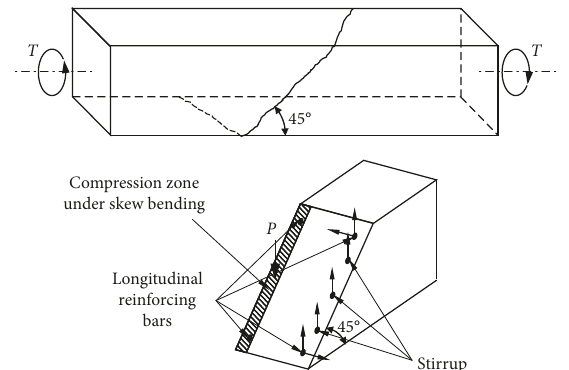
Figure 2: Skew bending theory [7,